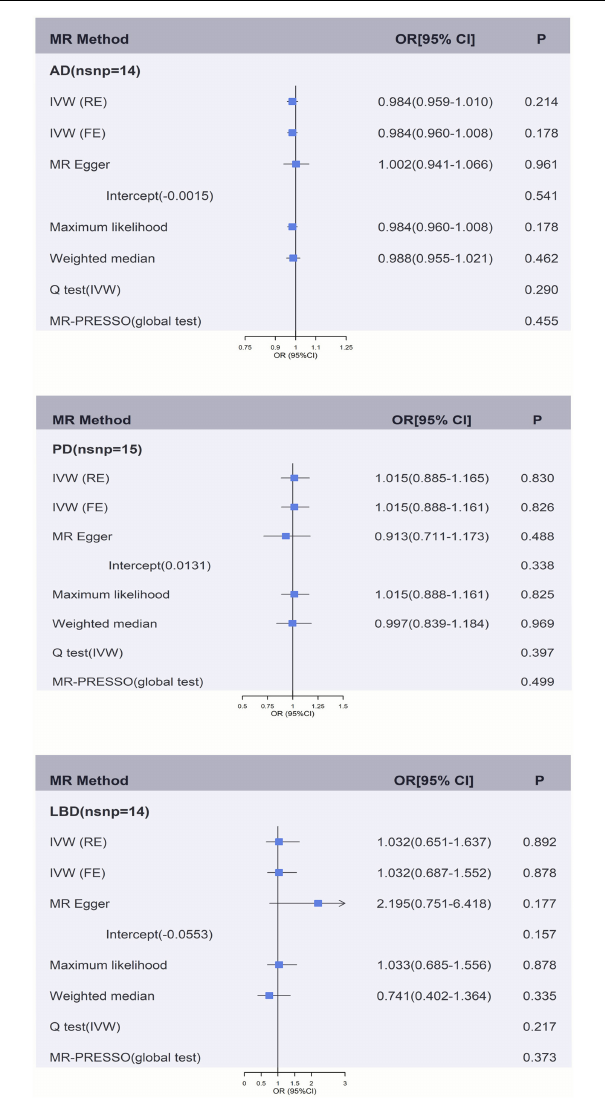
FIGURE 3 | Genetically predicted γ -fibrinogen levels with risk of AD, PD, and LBD. Results of the primary MR and sensitivity analyses. Estimated ORs per unit increase in log-transformed γ -fibrinogen for each outcome. AD, Alzheimer’s disease; IVW, Inverse variance weighting; LBD, Lewy body dementia; FE, fixed effects; MR, Mendelian randomization; OR, odds ratio; PD, Parkinson’s Disease; RE, random effects.